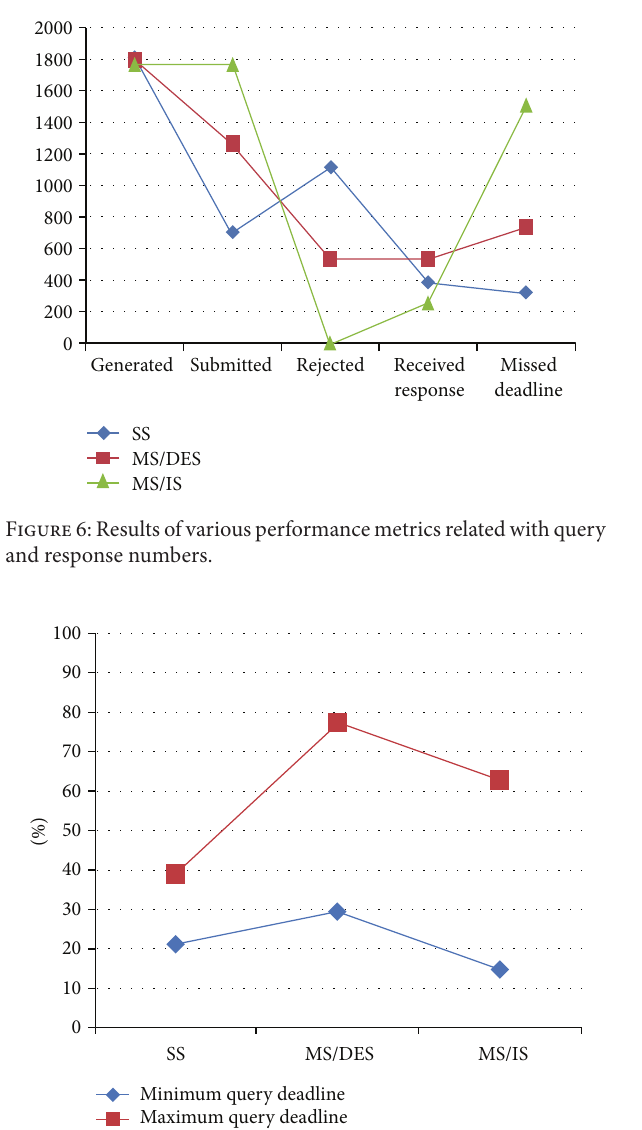
Figure 7: Results of Successful Query Ratio for different query deadline values.